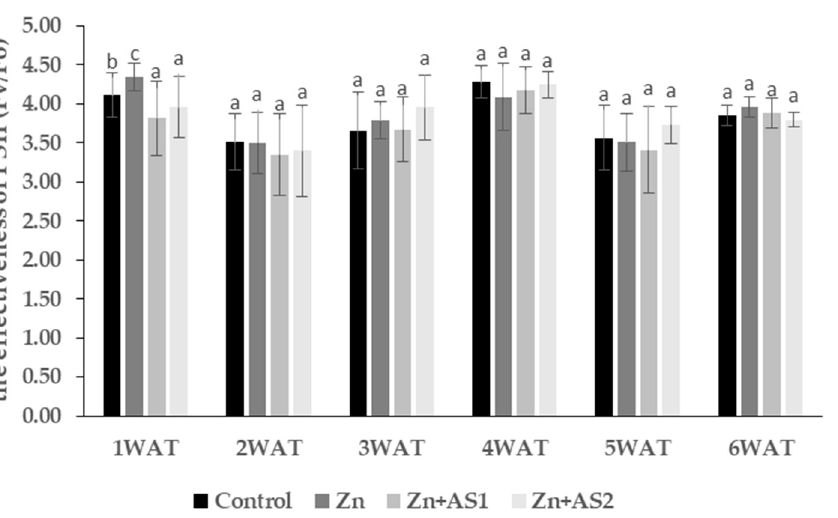
Figure 11. The effect of different foliar treatments (Zn, Zn+AS1, and Zn+AS2) on the effectiveness of PSII in the second youngest and fully developed leaves of maize 1, 2, 3, 4, 5, and 6WAT. N = 20 ± S.D. Lower case letters (a, b, and c) show the significant differences among the treatment based on sampling time. WAT: week(s) after treatment.